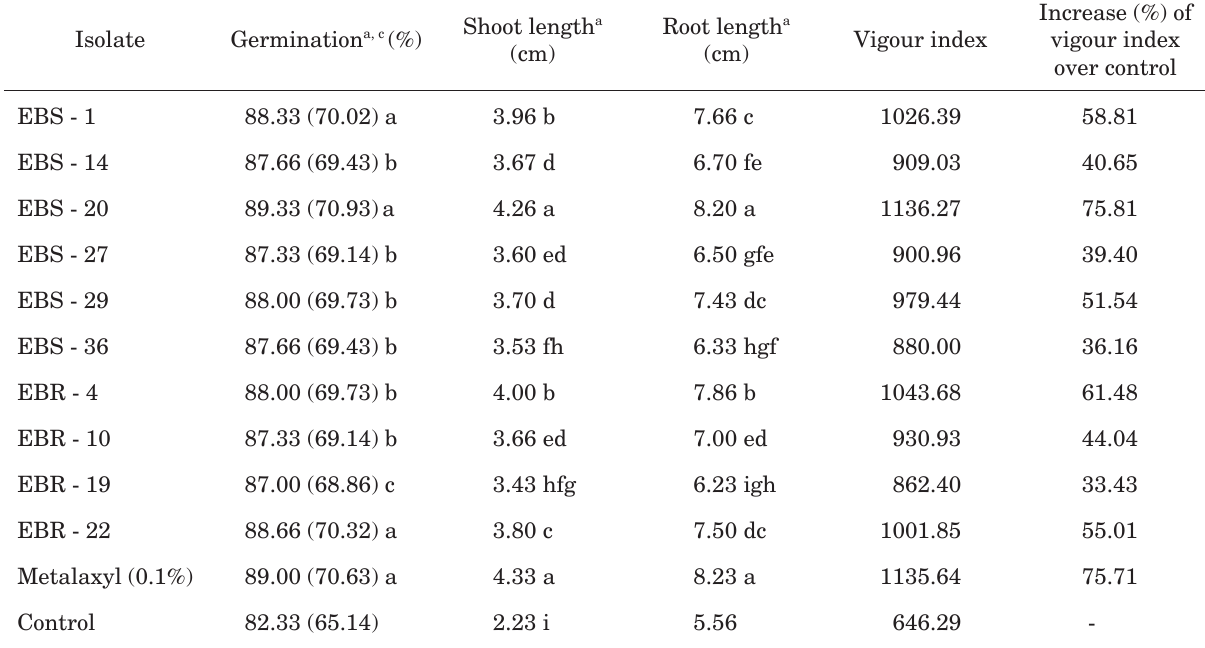
Table 4. Effect of effective endophyte isolates on chilli seedling growth.